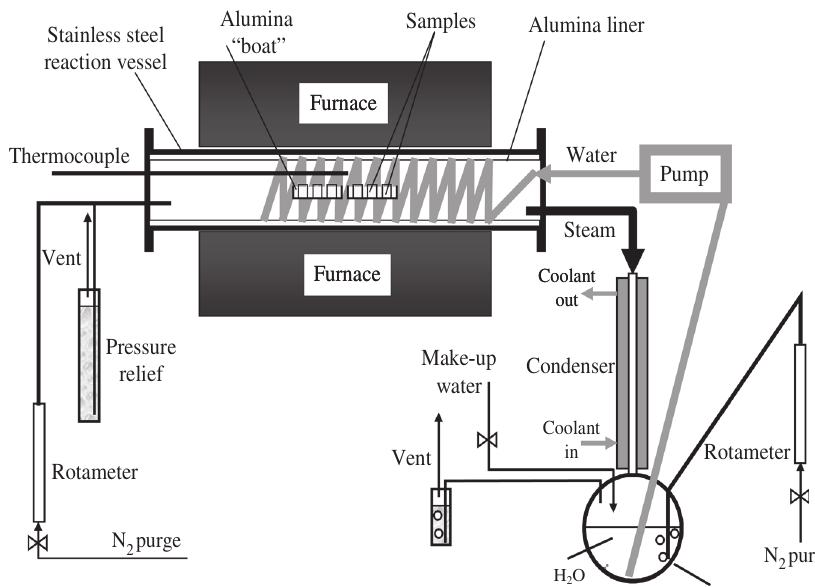
Figure 2: Steam oxidation rig used in this